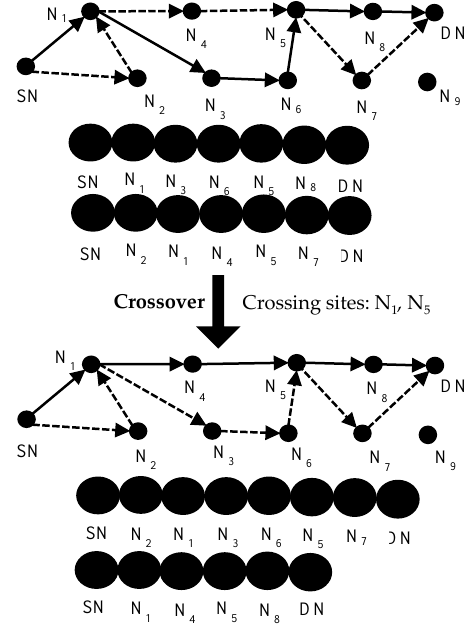
Figure 4. The two-point crossover procedure.